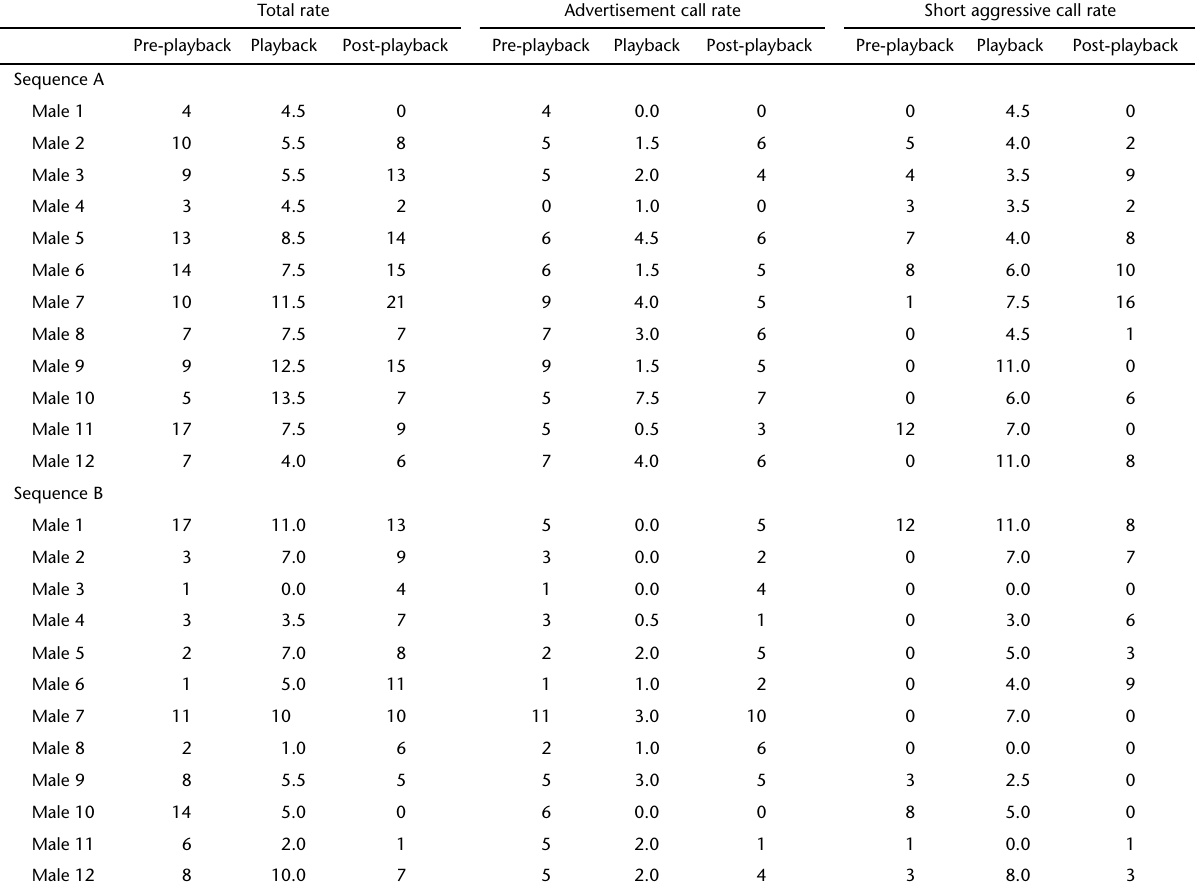
Table II. Number of calls emitted by H. goianus males during field playback experiments (sequences A and B), Floresta Nacional de Silvânia, municipality of Silvânia, state of Goiás,